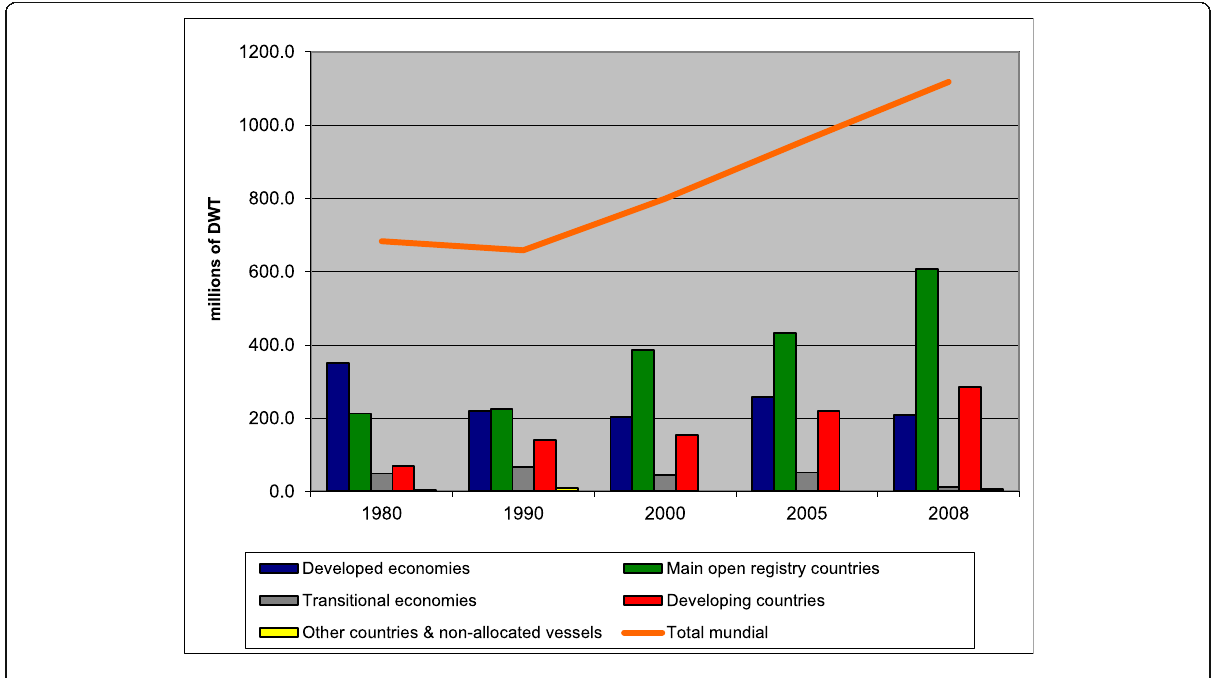
Fig. 1 Trend in fleet capacity (in DWT) by groups of countries and the global total, 1980 – 2008. Source: Own elaboration based on data from UNCTAD (several